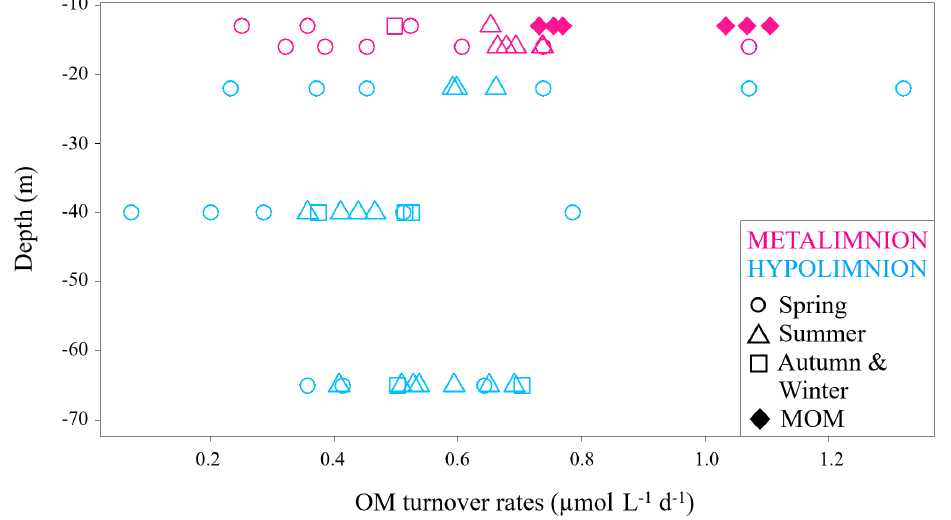
Figure 5. DIC production rates at specific depths of the hypolimnion and the metalimnion during the study period, marked with different symbols according to their sampling season. MOM samples only belong to summertime and are displayed as diamond